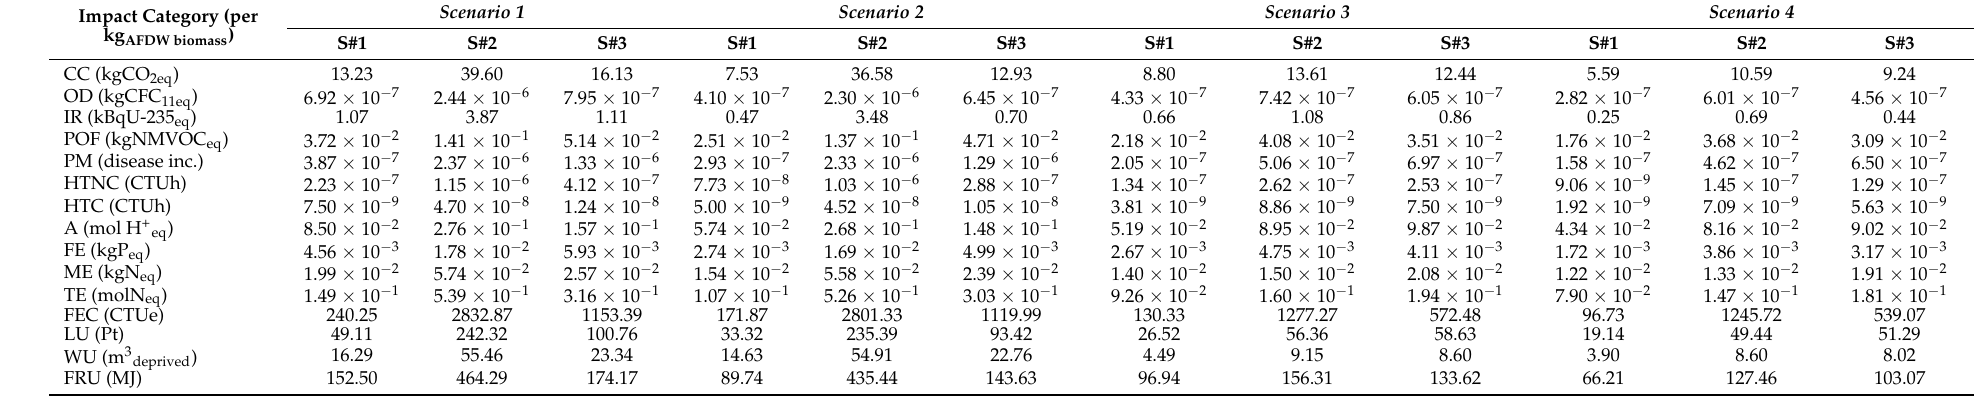
Table 5. Environmental impacts for each strain for the considered scenarios. Impact categories: CC—climate change; OD—ozone depletion; IR—ionizing radiation; POF—photochemical ozone formation; PM—particulate matter; HTNC—human toxicity, non-cancer; HTC—human toxicity cancer; A—acidification; FE—freshwater eutrophication; ME—marine eutrophication; TE—terrestrial eutrophication, FEC—freshwater ecotoxicity; LU—land use; WU—water use; FRU—fossil resource